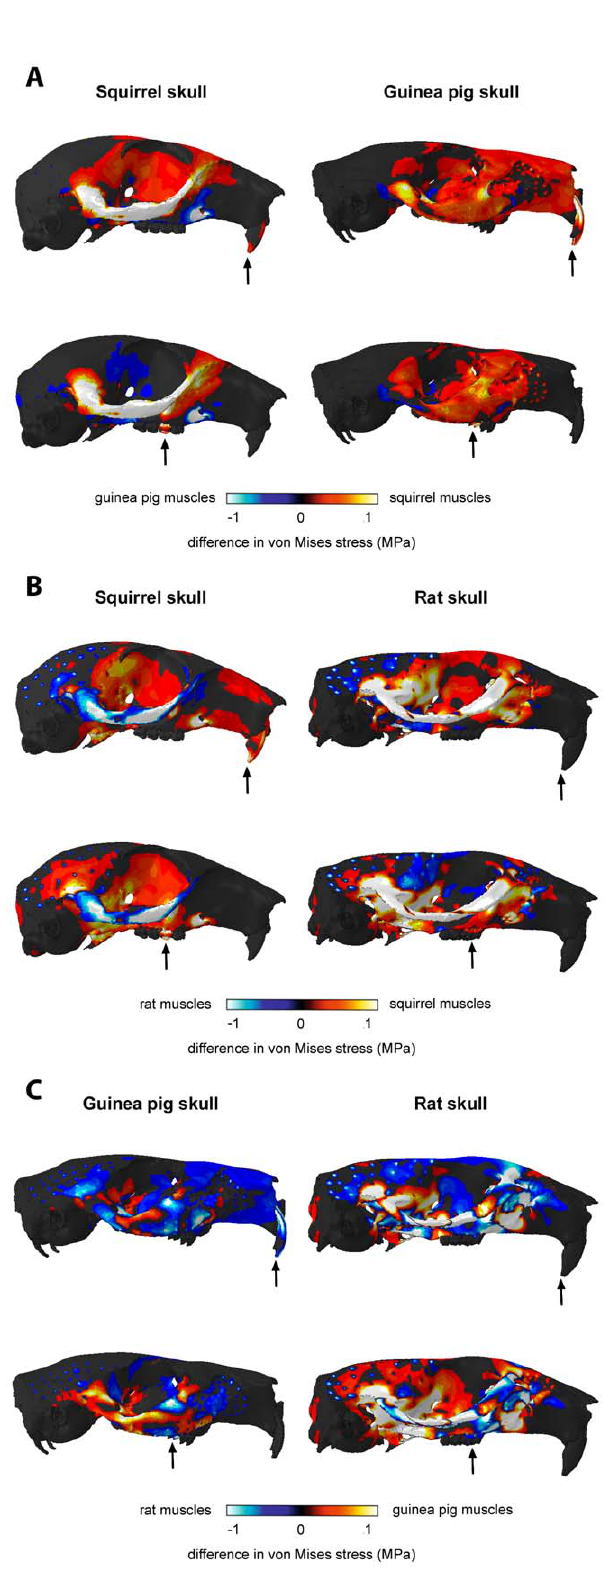
Figure 7. Contour maps showing the difference in von Mises stresses experienced by each model when loaded with different muscle configurations. (A) Stress generated by guinea pig muscles subtracted from stress generated by squirrel muscles. (B) Stress generated by rat muscles subtracted from stress generated by squirrel muscles. (C) Stress generated by rat muscles subtracted from